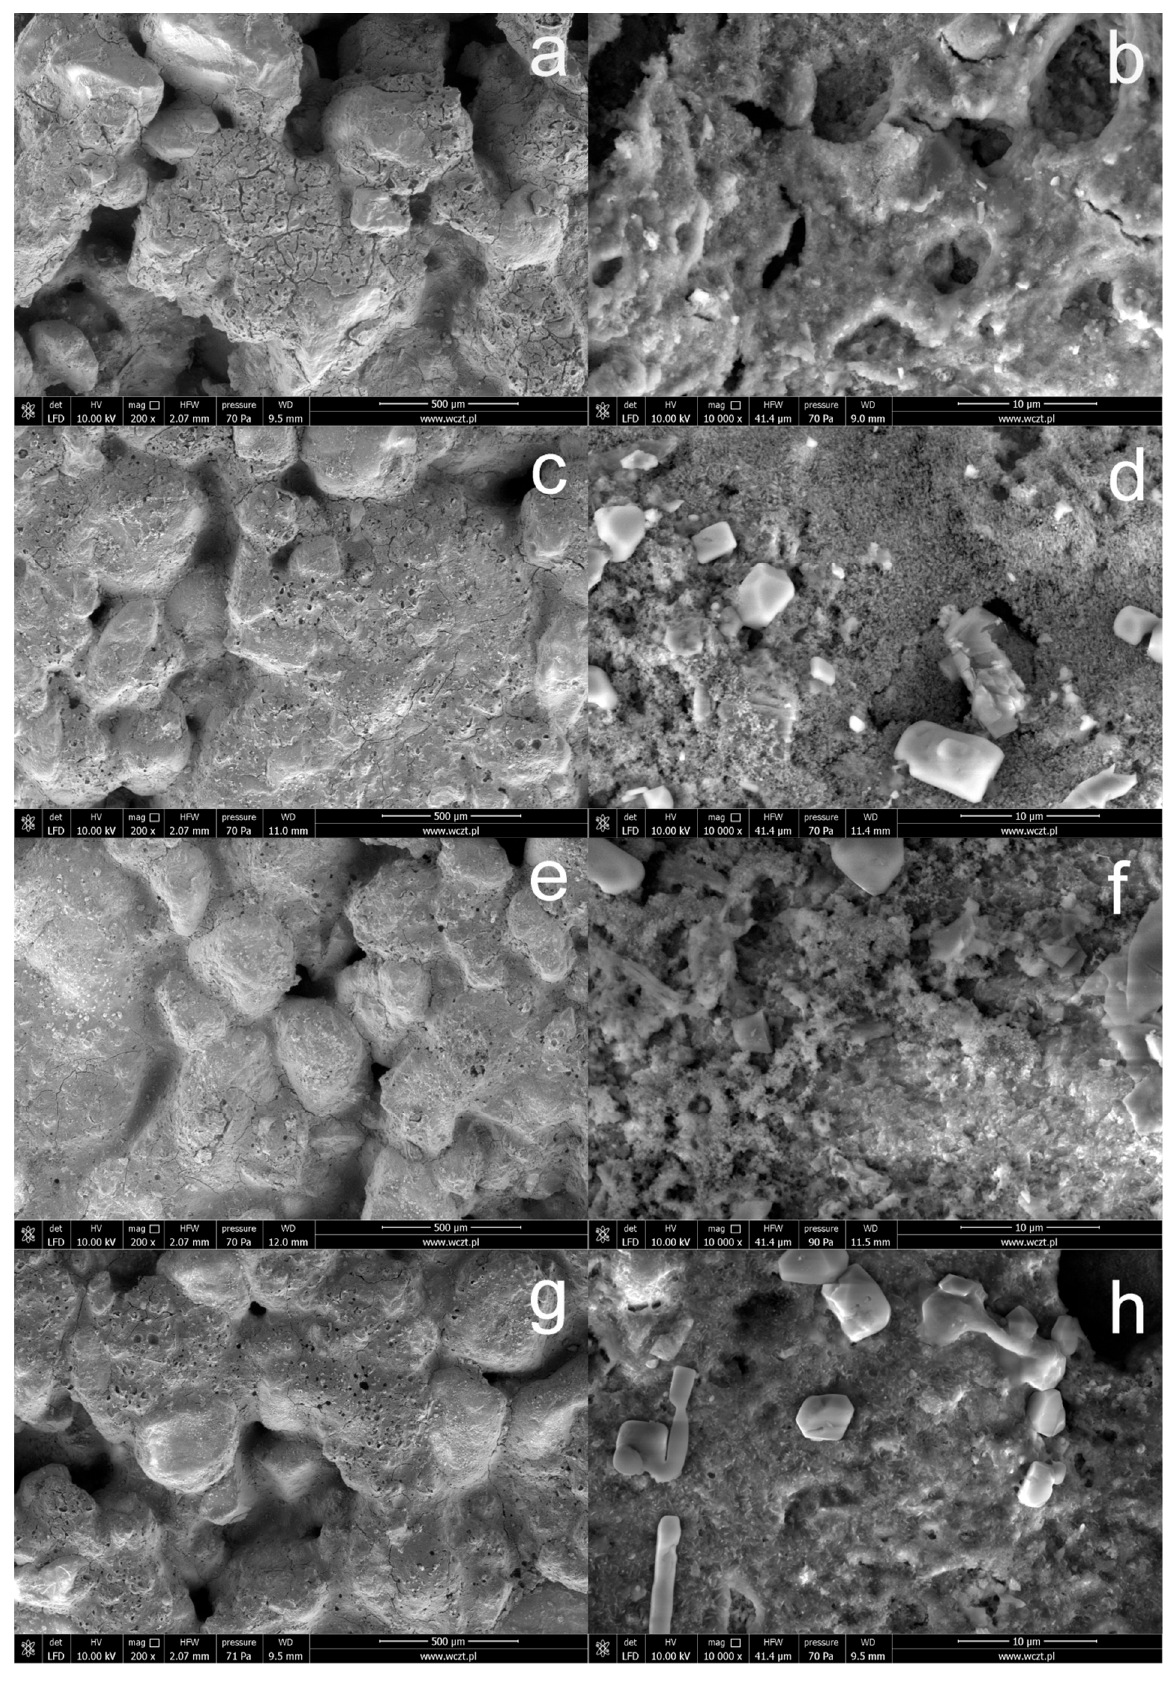
Figure 4. SEM images of concrete with a modified surface by OFTES/TEOS solutions: sample F1_4 ( a , b ), F2.5_2.5 ( c , d ), F4_1( e , f ), and F5_5 ( g , h ).